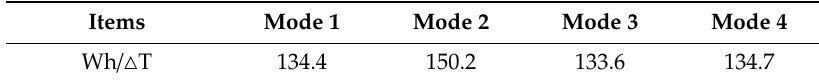
Table 6. Energy use e ff